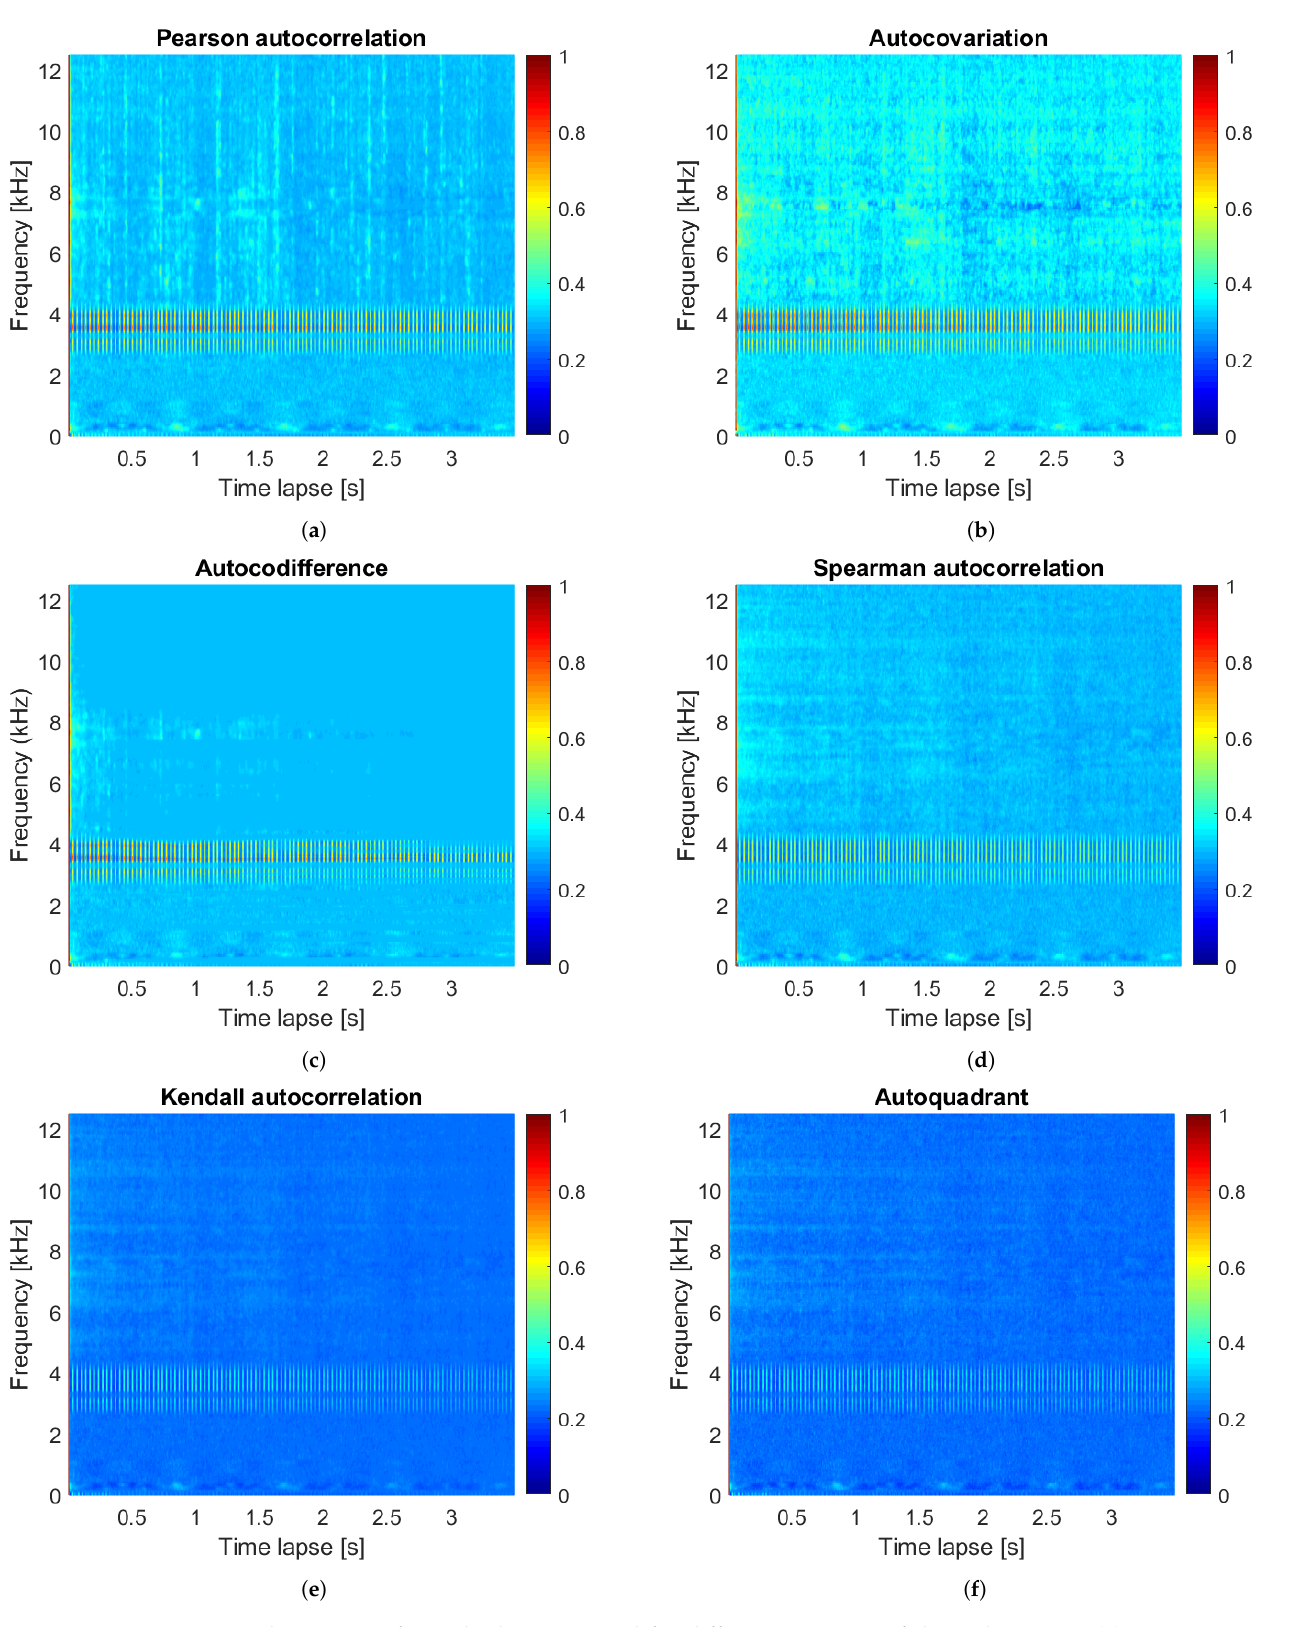
Figure 15. Auto-similarity maps for real vibration signal for different measures of dependence, i.e., ( a ) Pearson au- tocorrelation, ( b ) autocovariation, ( c ) autocodifference, ( d ) Spearman autocorrelation, ( e ) Kendall autocorrelation and ( f ) Quadrant